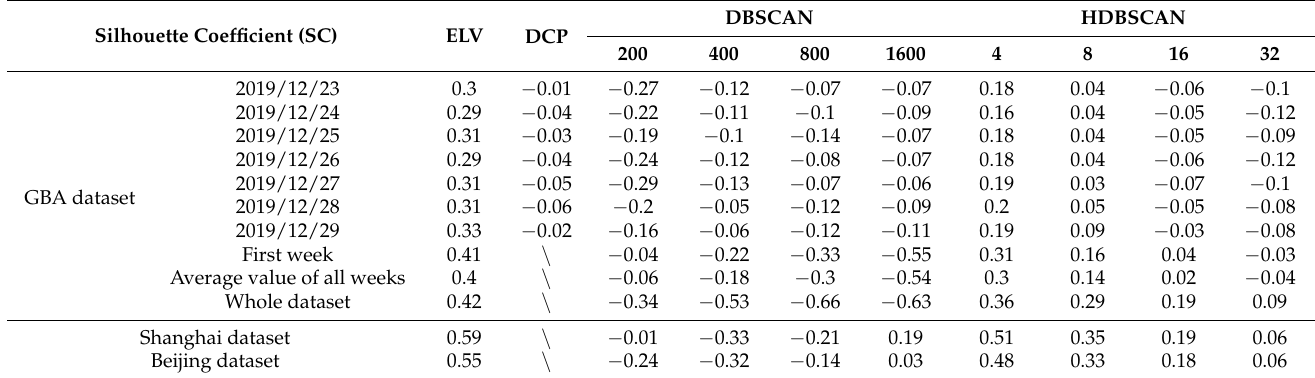
Table 4. Evaluation results of the different methods on the datasets based on SC.